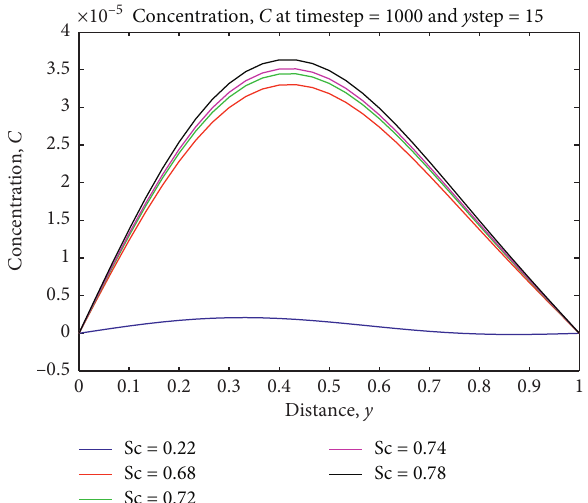
Figure 13: Effects of Schmidt number on concentration profile.